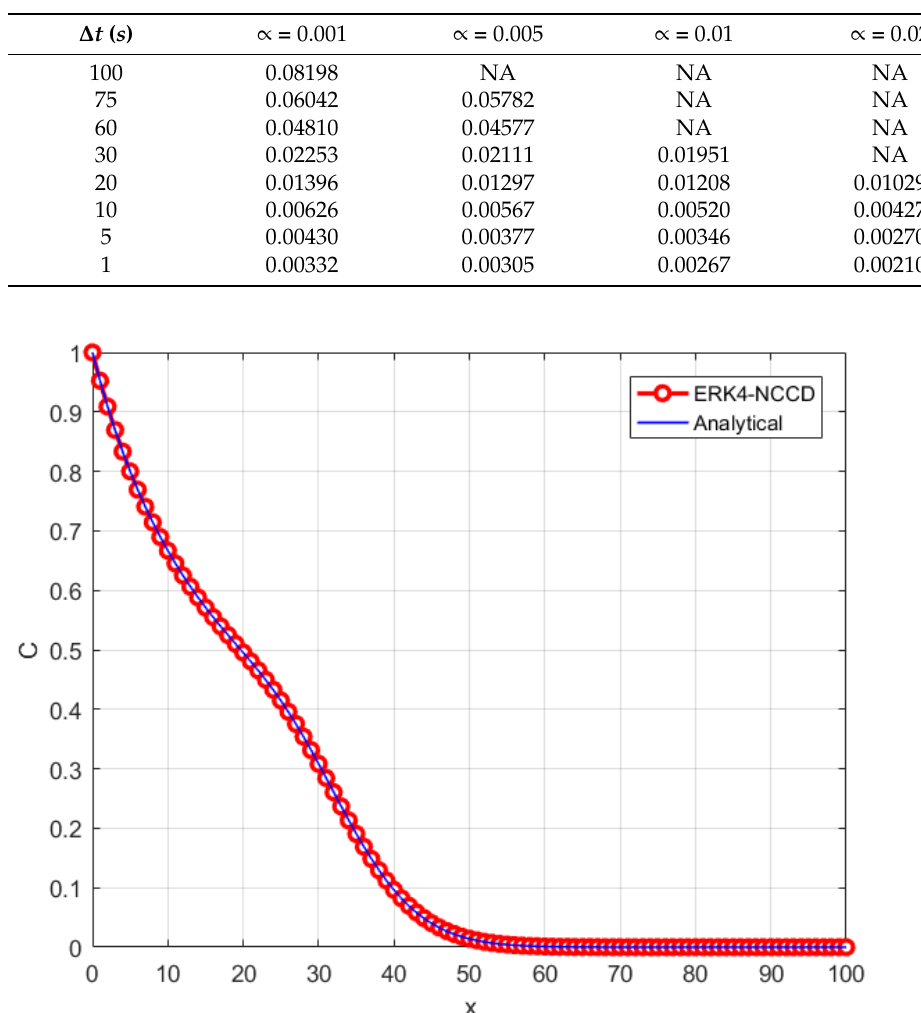
Figure 3. Analytical and numerical solution of the ADE with spatially and temporally variable parameters at t = 2000 s for ∆ t = 1 s, m = 0.1 s − 1 , and ∝ = 0.05 m − 1 .